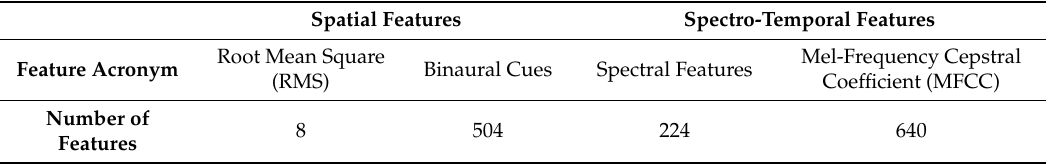
Table 3. Overview of the extracted features (1376 metrics in